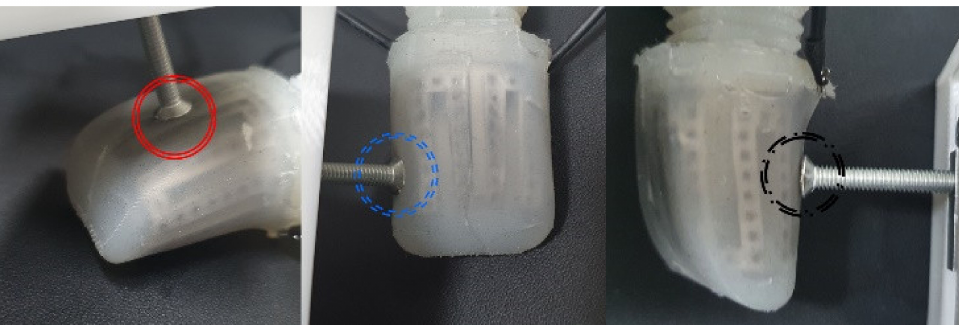
Figure 23. ( Left ) Front, ( Middle ) side, and ( Right ) back of fingers applying pressure to a nail in position-based characteri- zation